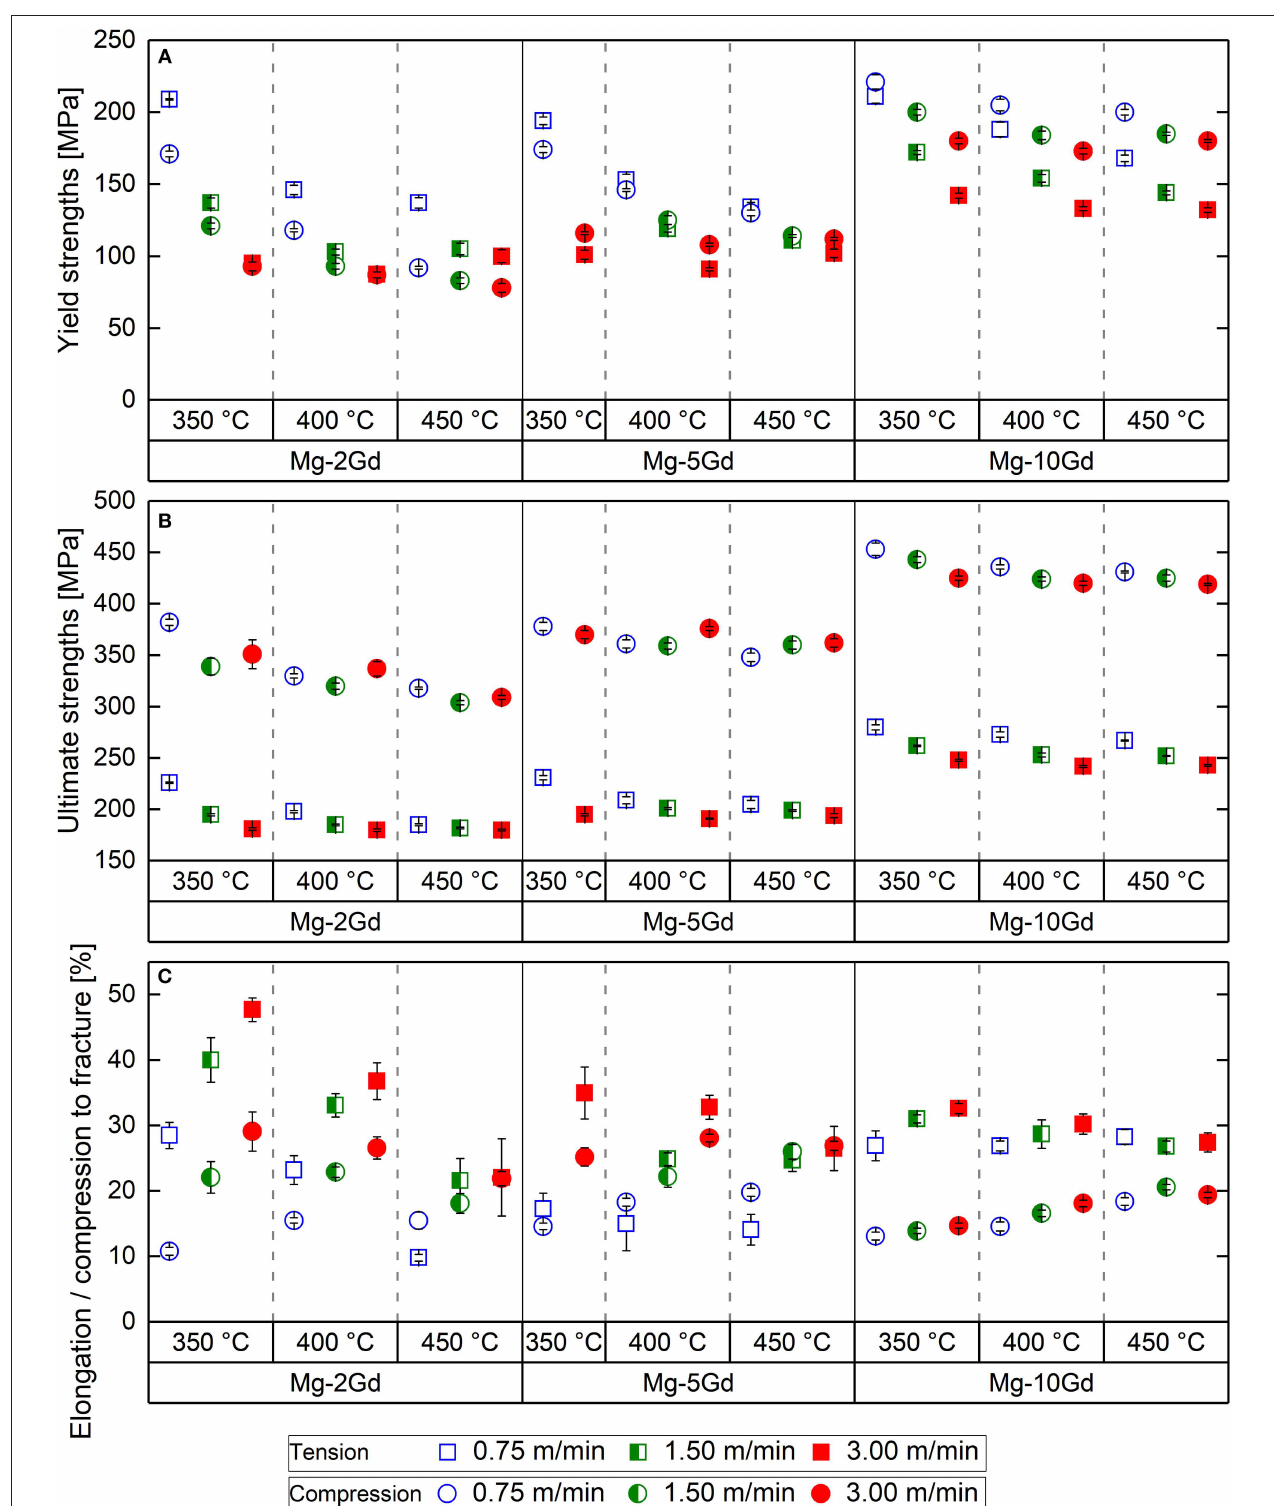
FIGURE 6 | Mechanical properties from tension and compression with respect to extrusion parameters. (A) Yield strengths, (B) ultimate strengths, and (C) elongation and compression to fracture.